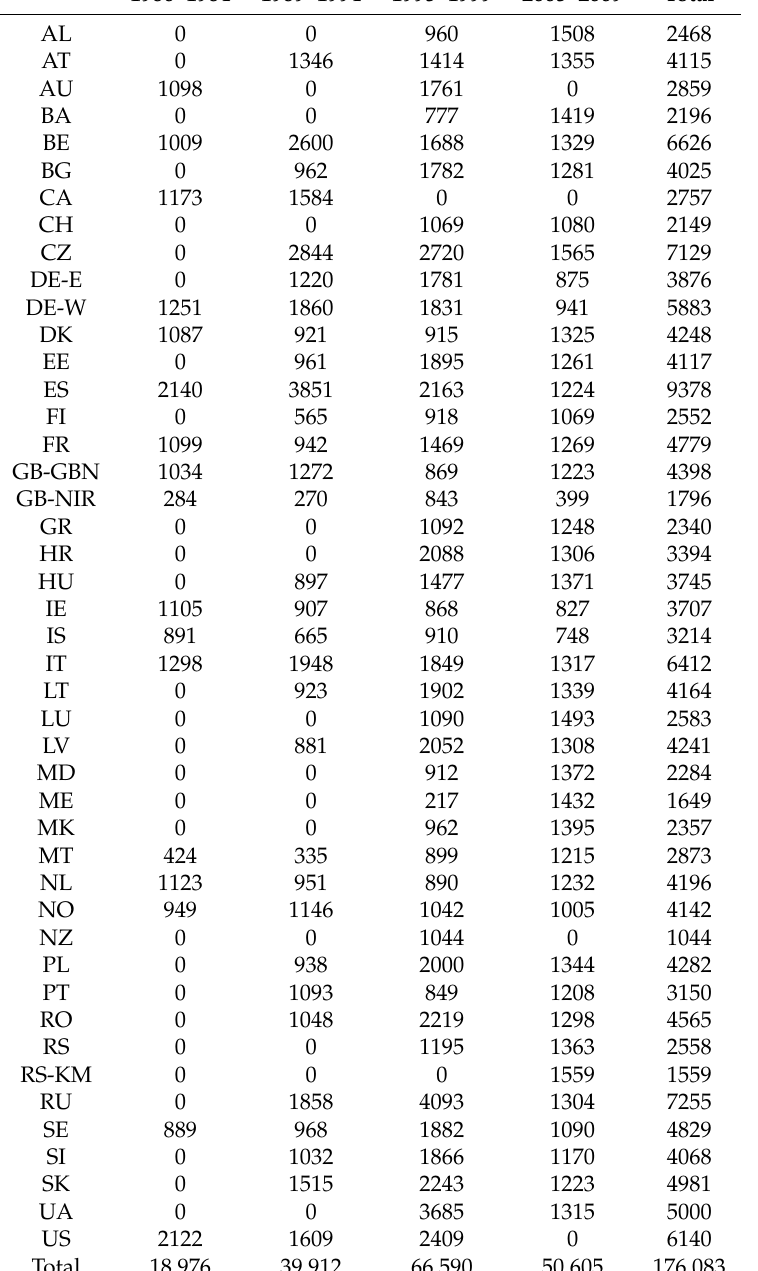
Table A9. The number of observations for the importance of good pay by country and